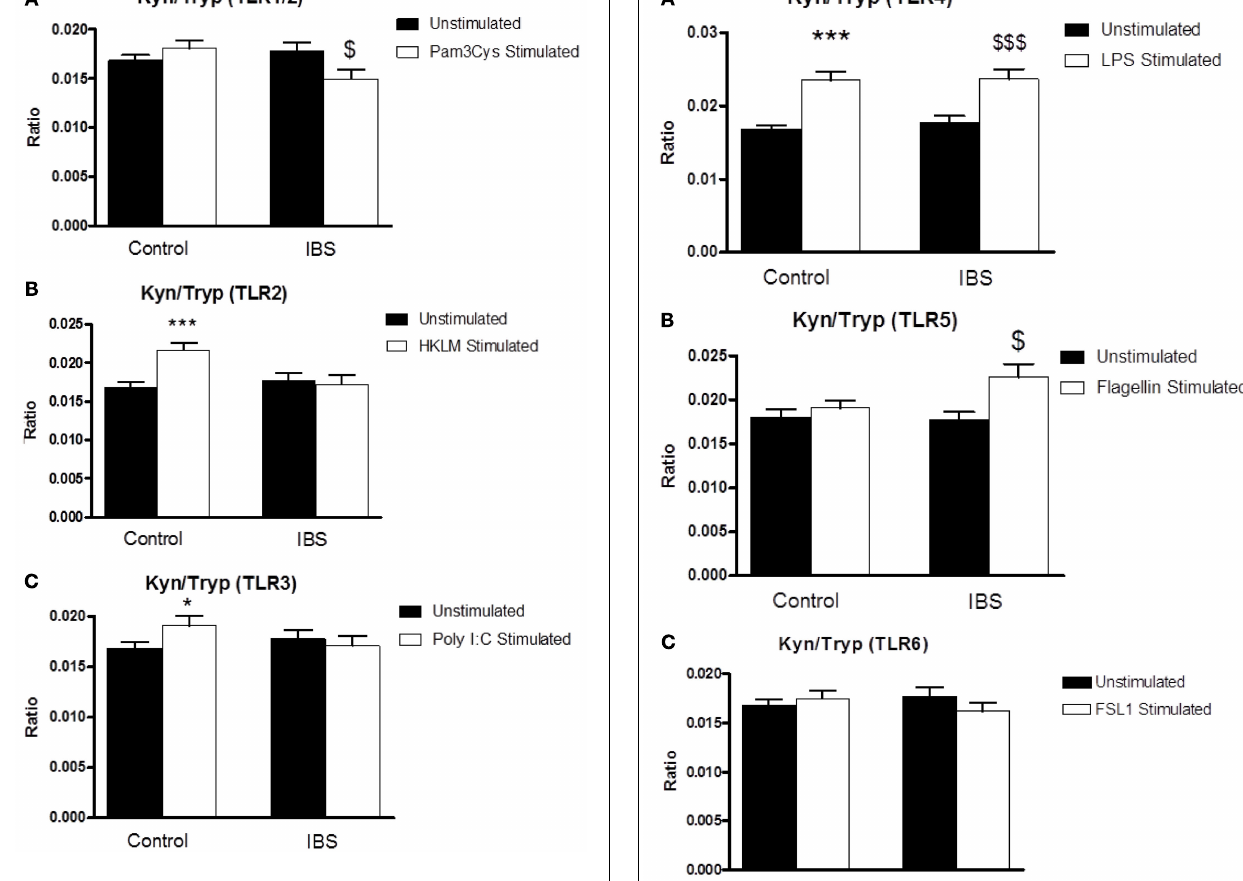
FIGURE 2 | Kynurenine:tryptophan (Kyn:Tryp) ratio in unstimulated whole blood supernatants from healthy controls and IBS patients and following stimulation with: (A)TLR1/2 agonist Pam3Csk, (B)TLR2 agonist HKLM, and (C)TLR3 agonist Poly I:C. Data are expressed as mean ± SEM. Statistical differences between treatments and disease states were determined using two-way ANOVA with Bonferroni post hoc test. * p < 0.05, Healthy control stimulated vs. unstimulated; *** p < 0.001, healthy control stimulated vs. unstimulated; $ p < 0.05, IBS stimulated vs. unstimulated.